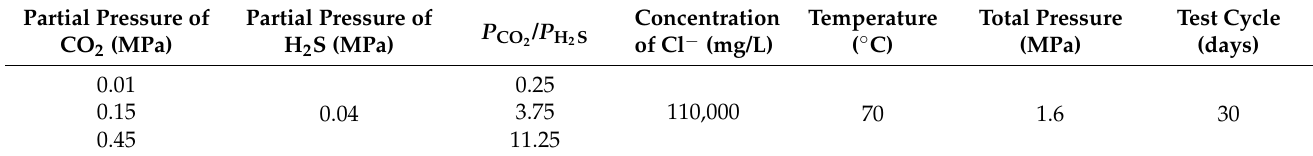
Table 3. Experimental conditions 1.